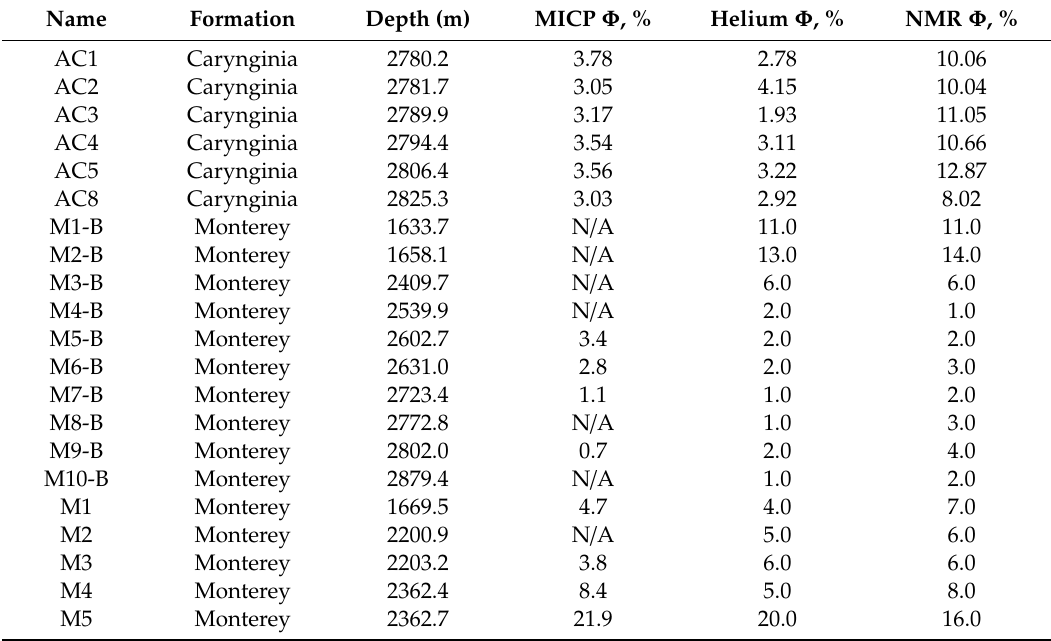
Table A1. The porosity values obtained from MICP, Helium and NMR techniques for the studied samples in Carynginia and Monterey. Some data are collected from other studies